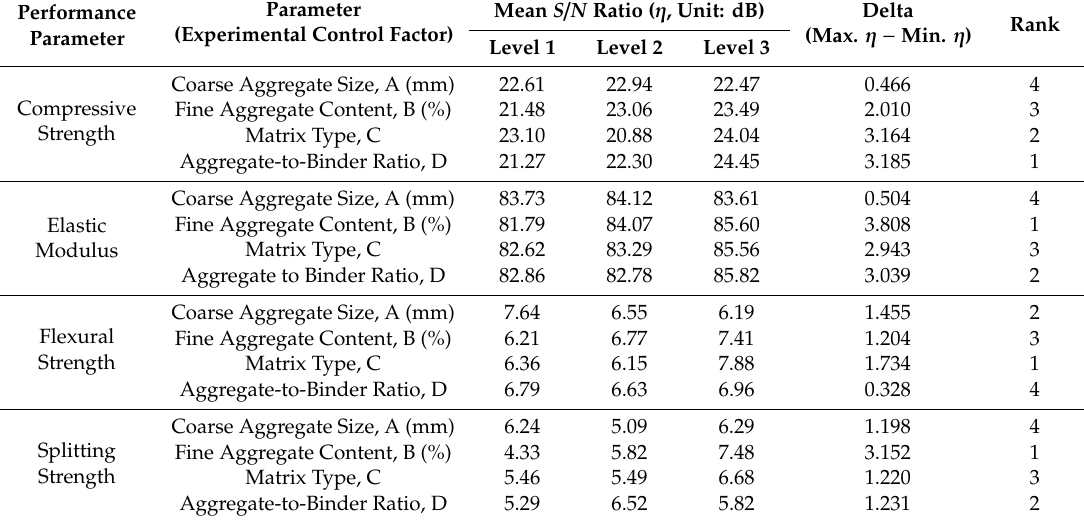
Table 14. Variance analysis and F test for pervious